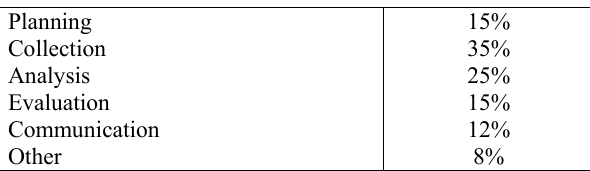
Table 5: Percentage of time spent on different elements of the intelligence